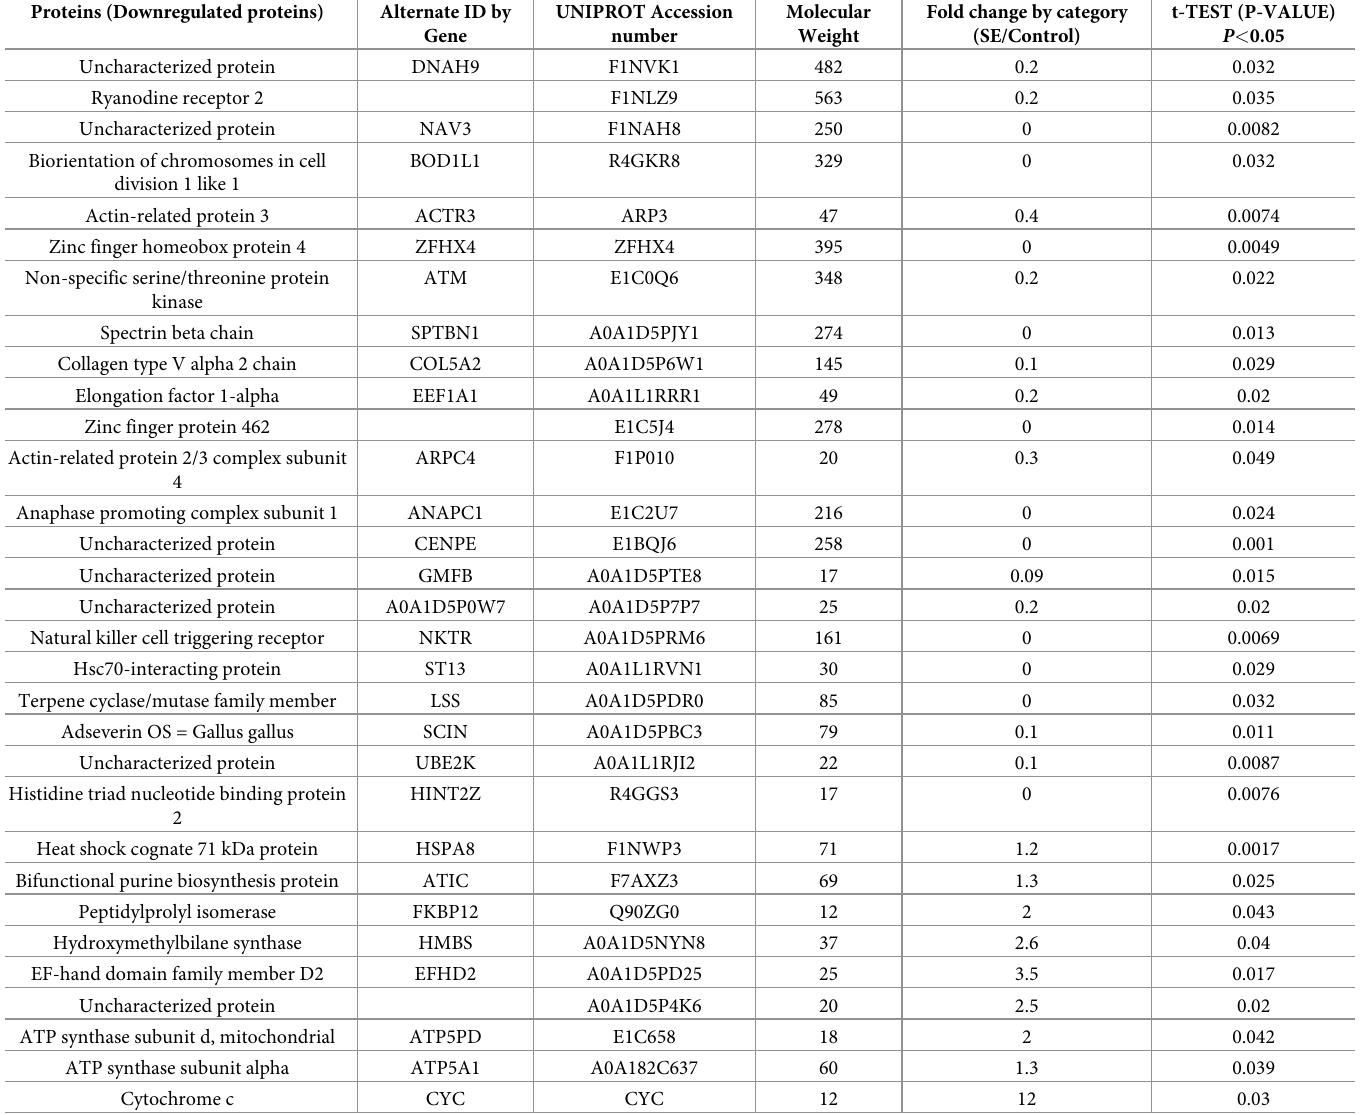
Table 1. Differentially regulated proteins in HTC cells after S . Enteritidis